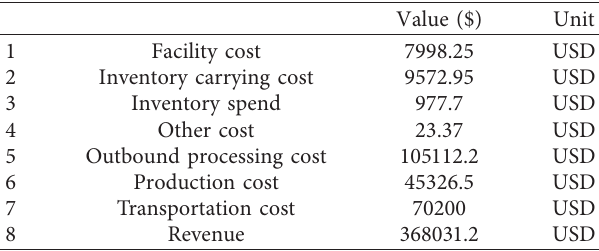
Table 2: Profit and loss